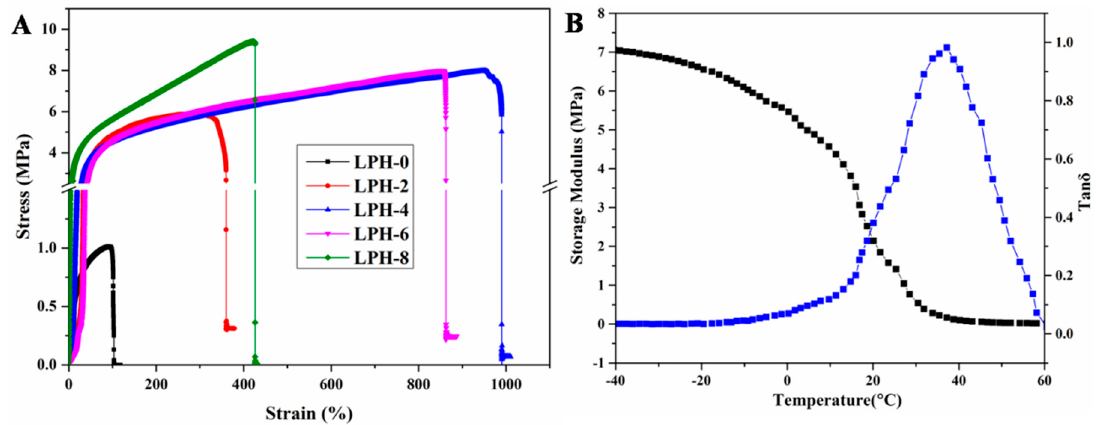
Figure 6. ( A ) The tensile stress–strain curves of LPH films and ( B ) dynamical mechanical analysis of LPH ‐ 8 for storage modulus and tan δ . Table 3. Mechanical properties of PHA ‐ based polyurethane films.